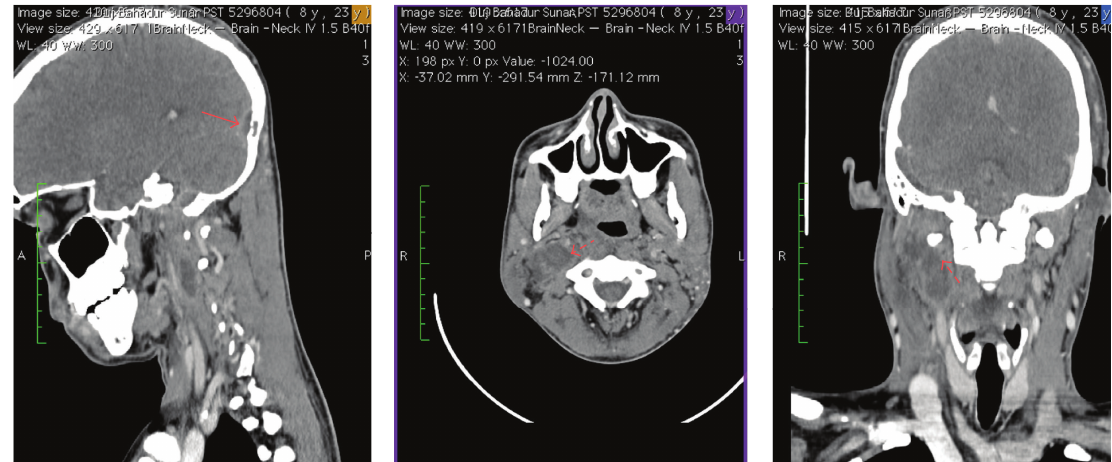
Figure 3: CECT showing right IJV thrombosis with right parapharyngeal abscess and delta sign at the transverse